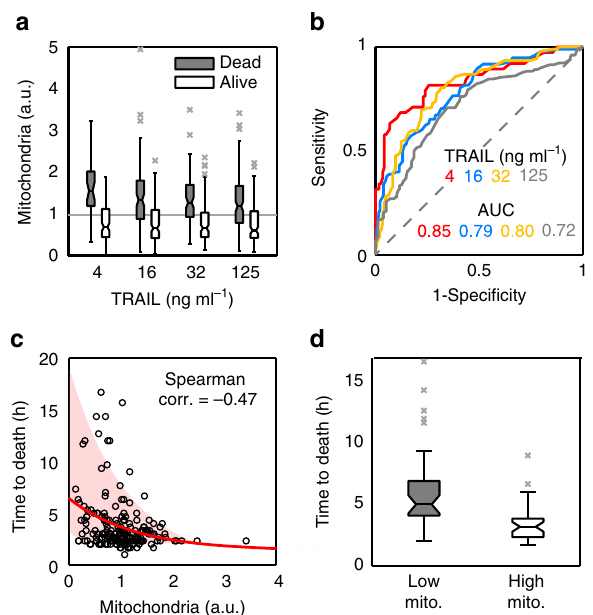
Fig. 2 In fl uence of mitochondrial content on apoptotic cell fate and times to death. HeLa cells stained with MG (as mitochondrial mass marker) were treated with different doses of TRAIL. After TRAIL addition, the cells were imaged for 24 h every 15 min. For each dose, we randomly selected cells from different images, quanti fi ed their initial mitochondrial mass by integrating MG intensity, and manually tracked their fate. Typically, we gathered ensembles of 250 – 300 cells so as to achieve between 100 and 150 apoptotic cells per dose. a Boxplots of mitochondrial levels of alive (white) and dead (grey) HeLa cells after 24 h of treatment. Mitochondrial values are normalised to average (grey line). Data are representative of six independent experiments. b Analysis of mitochondrial content as a binary classi fi er (death/life) of cell fate. To calculate the performance of mitochondria as classi fi er, the Receiver Operator Characteristic curve (ROC) and area under the curve (AUC) were represented and calculated for the different TRAIL doses. c Correlation between mitochondrial levels and time to death in apoptotic single cells treated with 32 ng ml − 1 of TRAIL. The red line is an exponential fi t and the shaded area indicates the con fi dence region for the fi t. d Boxplots of time to death for HeLa cells with mitochondrial levels in the fi rst quartile (Low mito, grey) and in the fourth quartile (High mito, white). Each boxplot was calculated with 30 cells. Boxes cover the range from the lower to the upper quartile of the data. Whiskers indicate maximum and minimum values, excluding outliers which are plotted as individual grey crosses. Horizontal lines inside the boxes represent median values, and notches indicate 95% con fi dence intervals for the